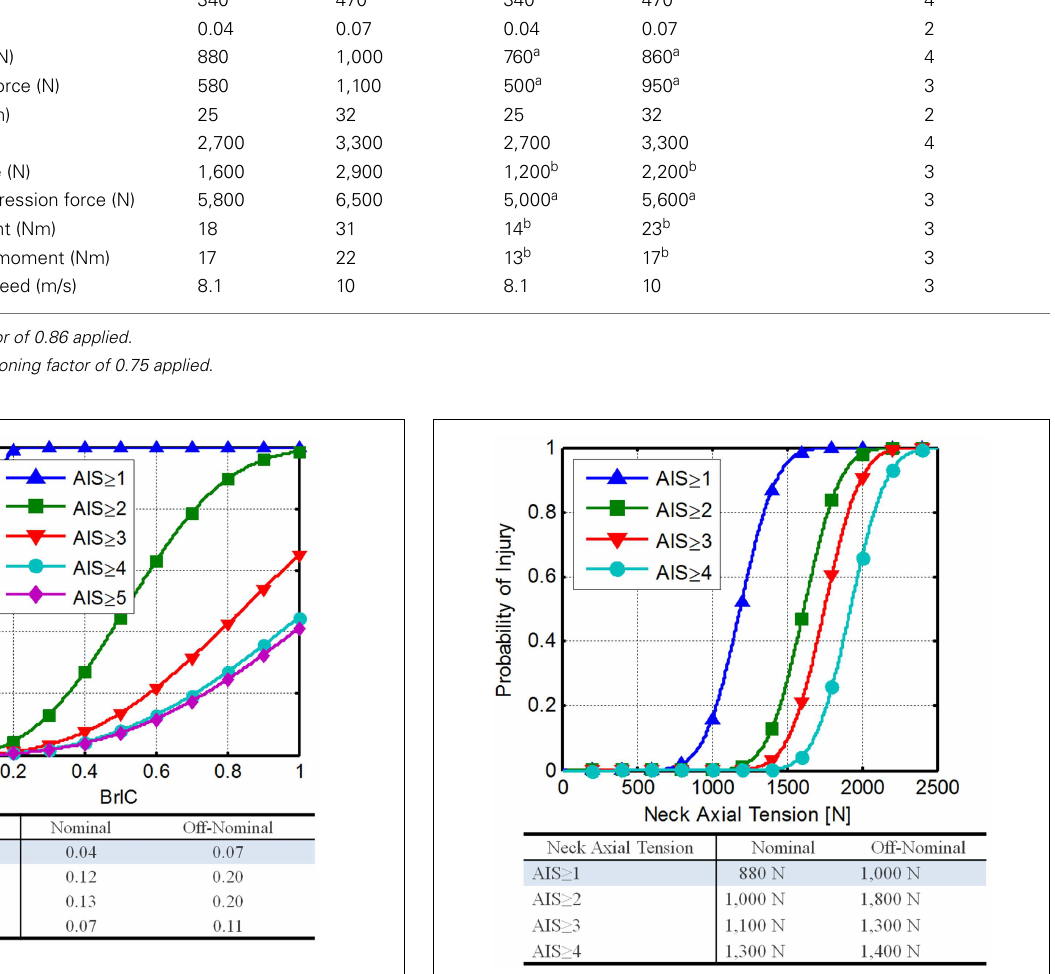
FIGURE 3 | Brain rotational injury criteriaTHOR injury risk functions (Saunders et al., 2012) . FIGURE 4 | Neck axial tension force risk functions developed from